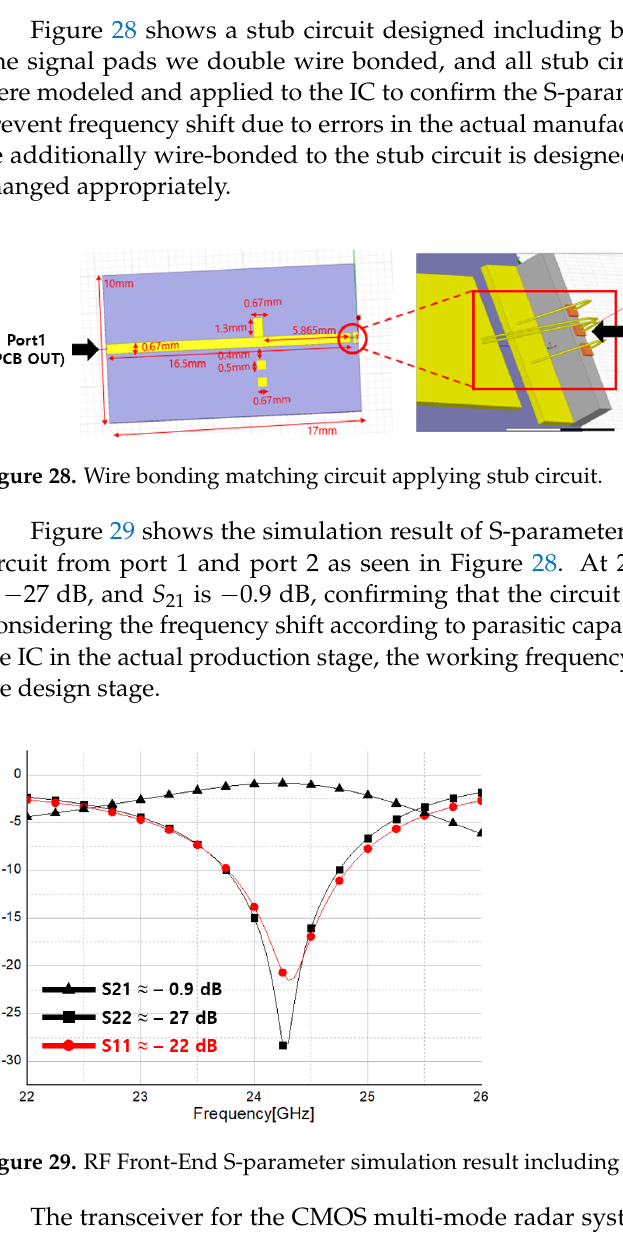
Figure 27. Simulated Q-factor and inductance of 3D modeled double bond wire.